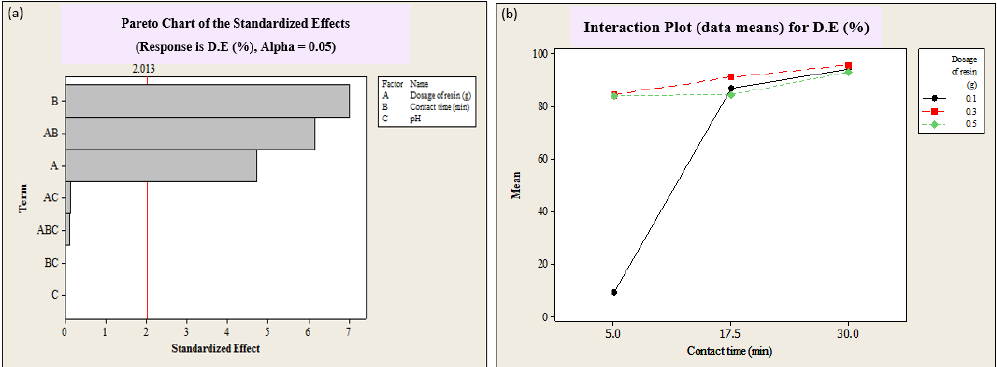
Figure 2. Pareto chart showing the effects and interactions of operational variables, namely dosage of resin (g), contact time (min) and pH, on the decolorization efficiency (D.E. (%)) by SIR ( a ) , and interaction plot of decolorization efficiency (D.E. (%)) by SIR versus contact time (min) for the different dosages of resin, namely 0.1, 0.2, and 0.3 g of SIR ( b ).